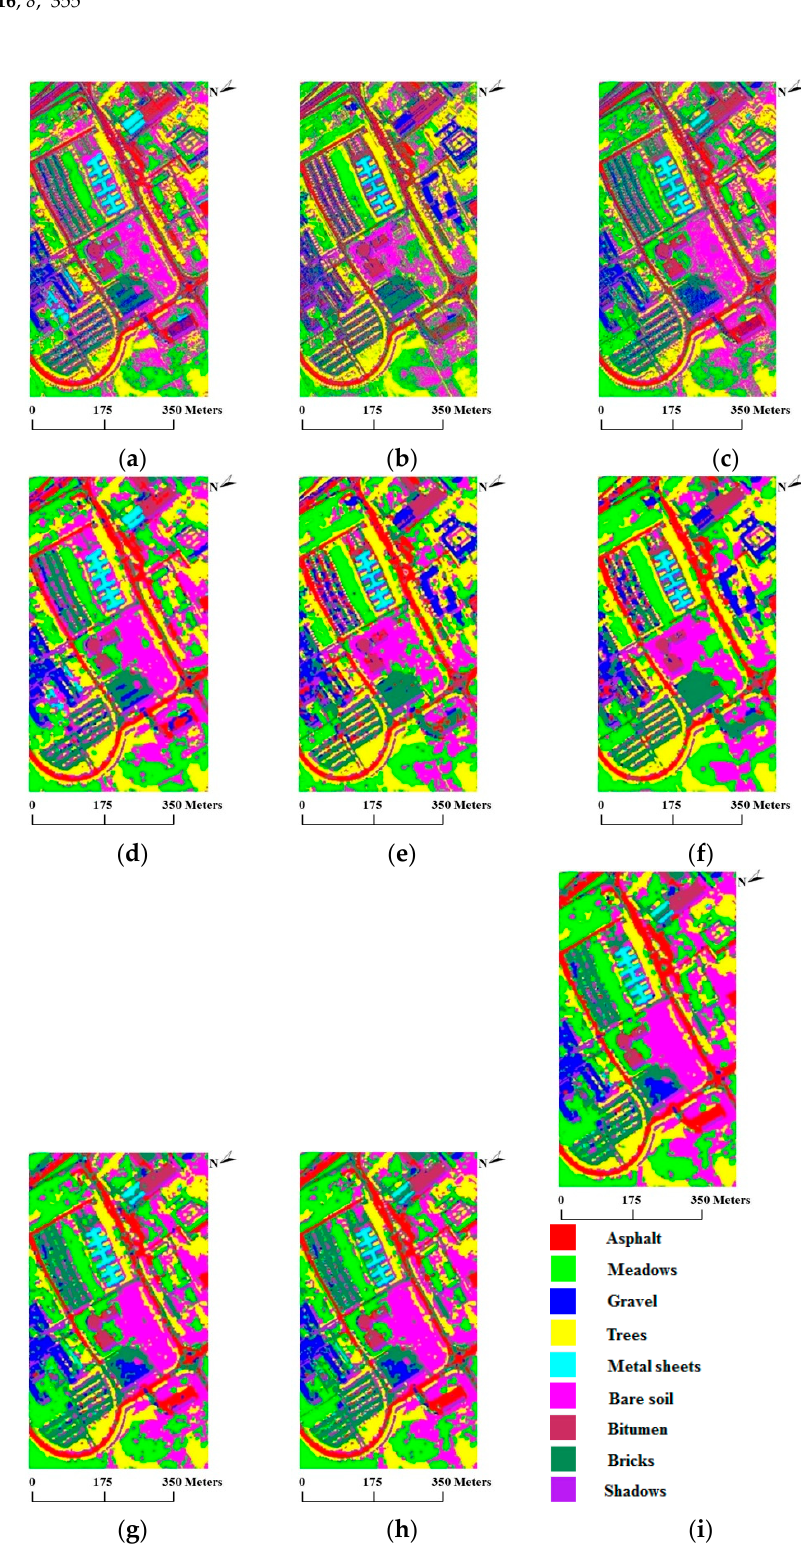
Figure 8. Classification/segmentation maps produced by the various tested methods for the ROSIS University of Pavia scene (overall accuracies are reported in parentheses). ( a ) SVM (69.70%); ( b ) MLRsub (66.84%); ( c ) SVMsub (71.38%); ( d ) SVM-MRF (75.71%); ( e ) MLRsub-MRF (72.97%); ( f ) MLRsub-aMRF (73.67%); ( g ) SVMsub-MRF (79.20%); ( h ) SVMsub-eMRF (79.84%); ( i ) SVMsub-aMRF (81.94%).